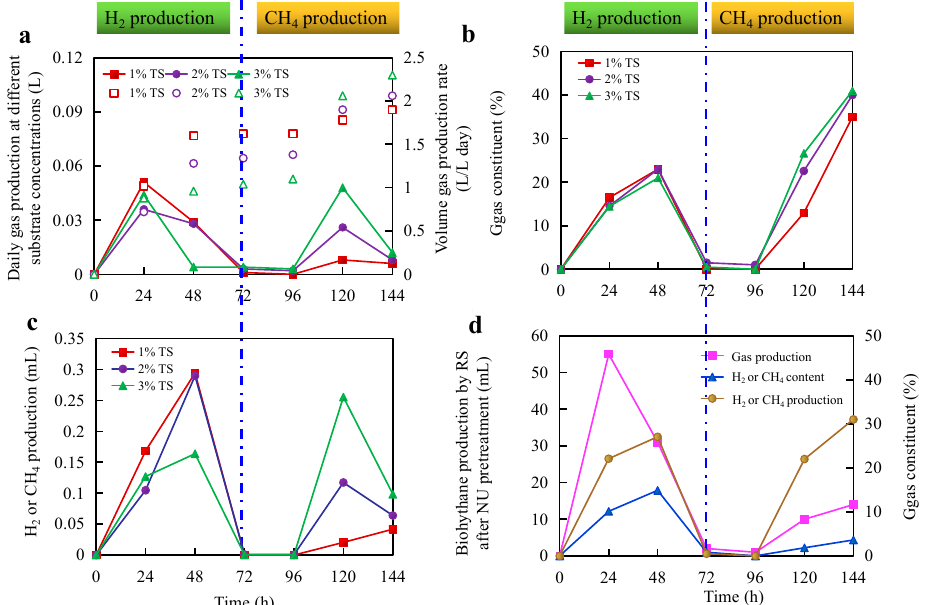
Figure 2. Optimization of substrate concentration of biohythane production: ( a ) gas production performance of untreated rice straw; ( b ) the content of H 2 and CH 4 in gas; ( c ) H 2 and CH 4 production of untreated rice straw; ( d ) the H 2 and CH 4 production performance of rice straw by NaOH/urea pretreatment at 100% solid loading under outdoor cold winter conditions for 3 months at 1% substrate concentration.